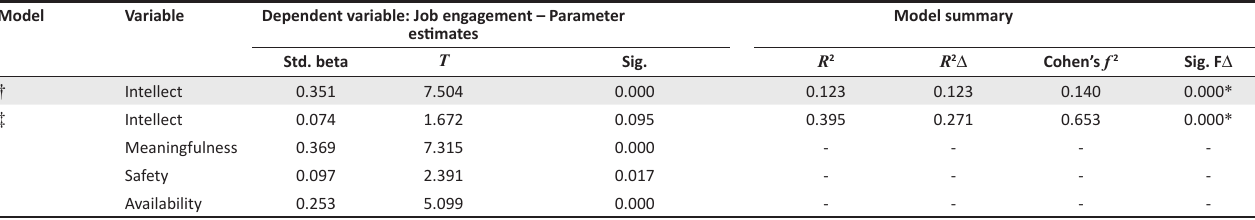
TABLE 8 : Hierarchical multiple regression analyses testing intellect and psychological conditions constructs in the prediction of job engagement. Model